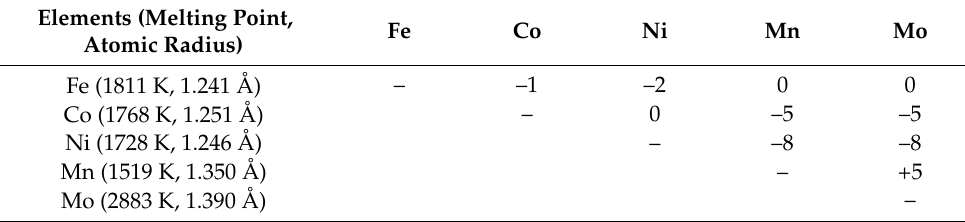
Table 3. Calculated values of valence electron concentration (VEC), enthalpy of mixing ( ∆ H mix ), mixing entropy ( ∆ S mix ), Ω , atomic size difference ( δ ), Allen electronegativity ( ∆ χ A ), and Pauling electronegativity ( ∆ χ P ) in the CoFeNiMnMo x alloys.